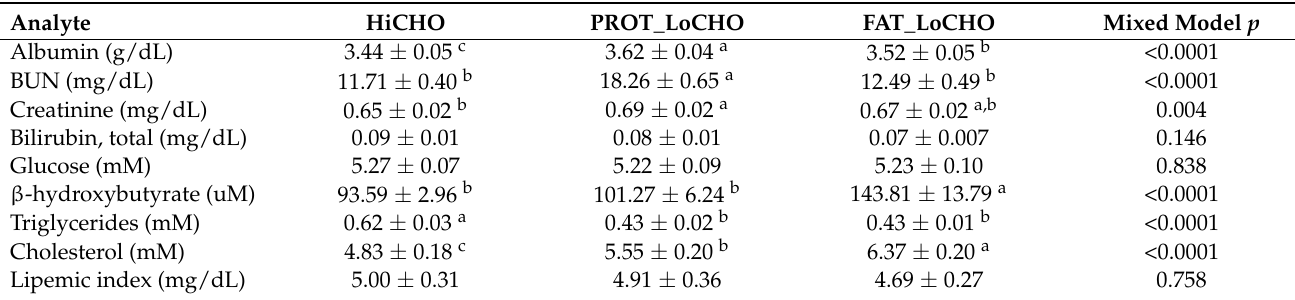
Table 3. Serum clinical